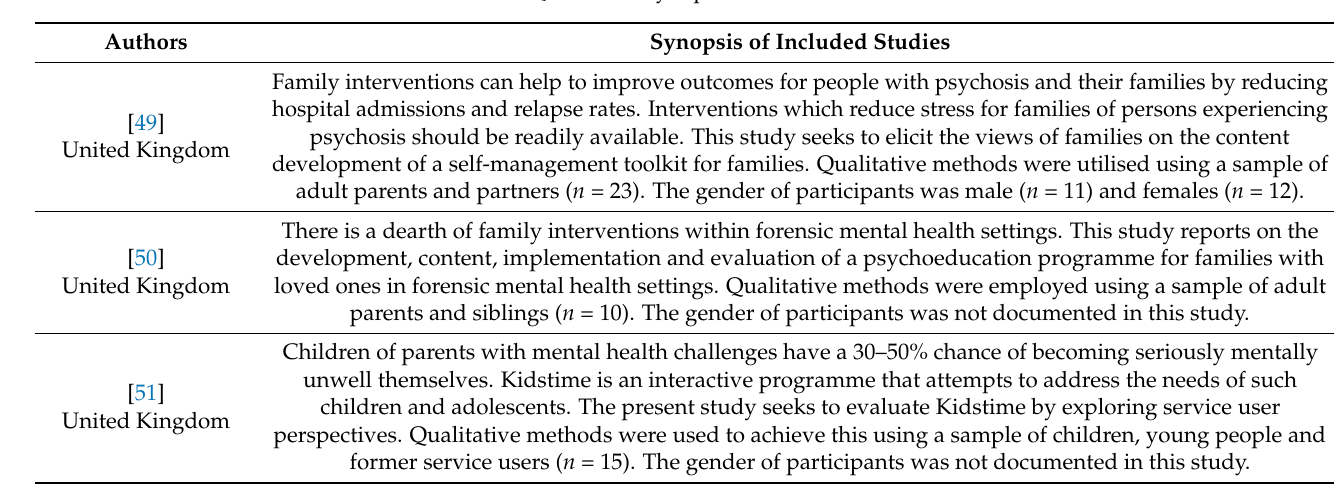
Table 4. Qualitative synopsis of included